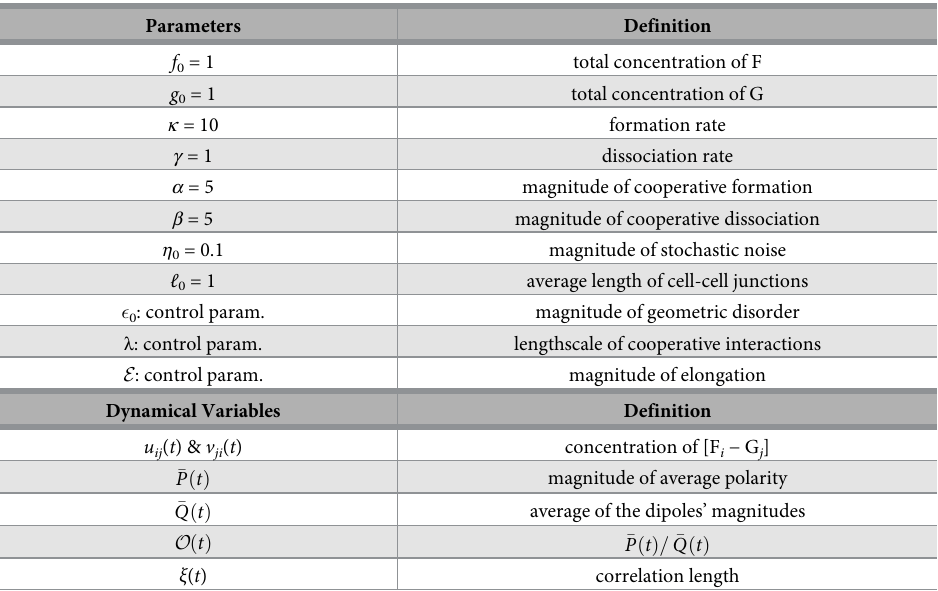
Table 1. List of parameters, variables and their definitions. The parameters with their values mentioned are held fixed throughout the paper. The control parameters, i.e. the geometric disorder � 0 , the length scale of the cooperative interactions λ , and the magnitude of elongation E , are to be varied to explore the behavior of polarization in different